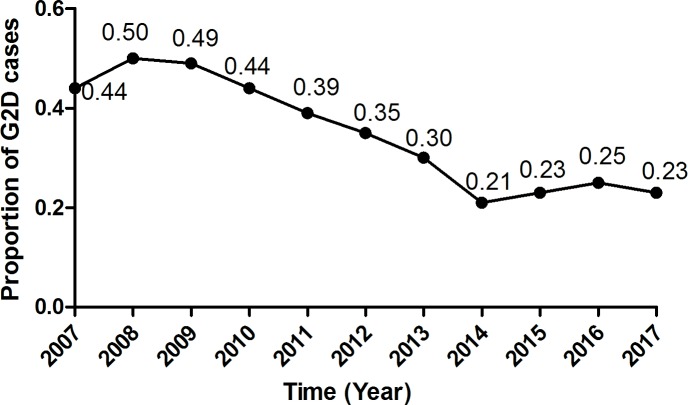
The proportion of G2D of newly detected leprosy cases over the years.